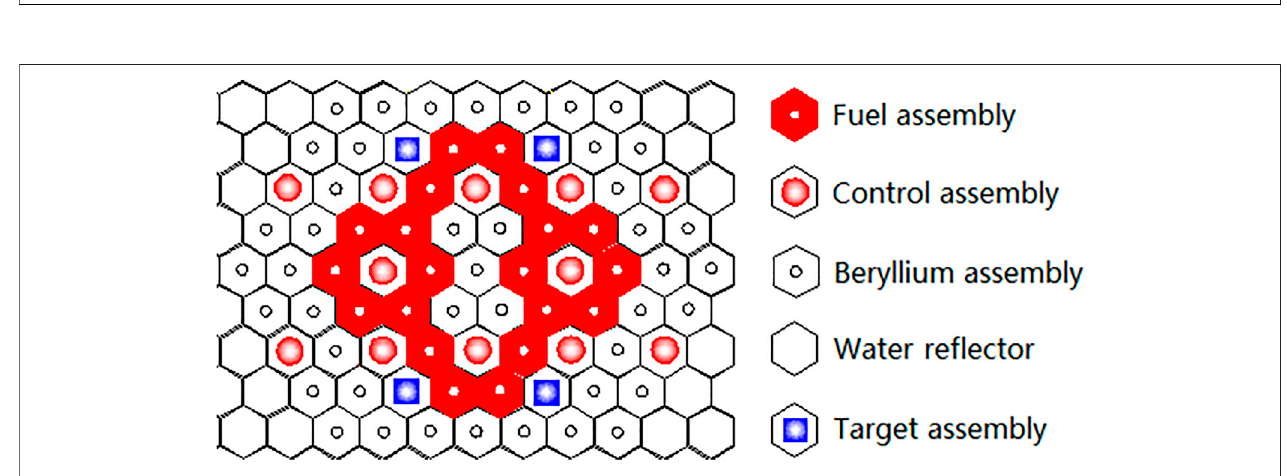
FIGURE 8 | Core arrangement of Scheme